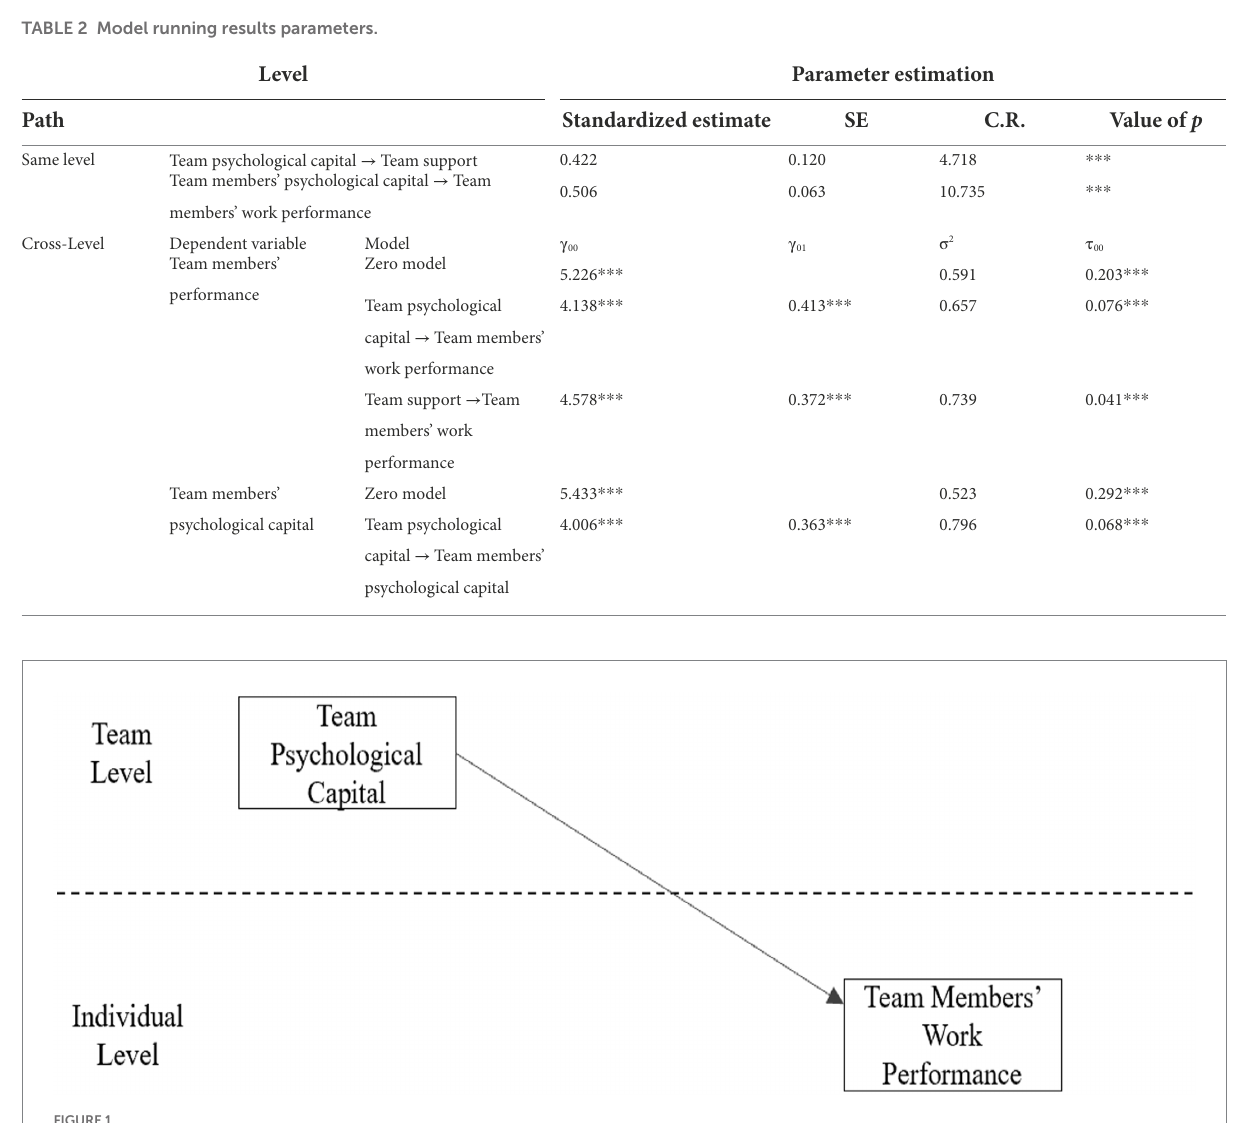
TABLE 2 Model running results parameters.